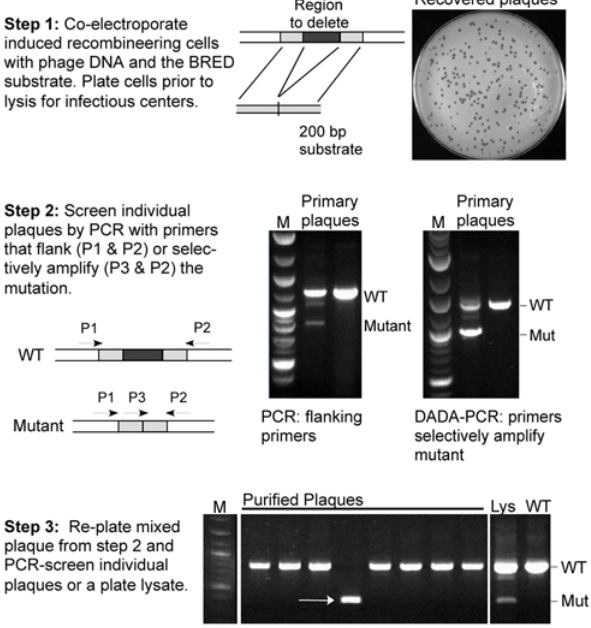
Figure 1. A simple three-step method for constructing bacteriophage mutants using BRED. In the first step, induced electrocompetent M. smegmatis mc 2 155 cells containing the recombi- neering plasmid pJV53 are co-transformed with phage DNA (50– 100 ng) and the recombineering substrate (50–500 ng); a 200 bp PCR- generated dsDNA substrate containing a centrally located mutation